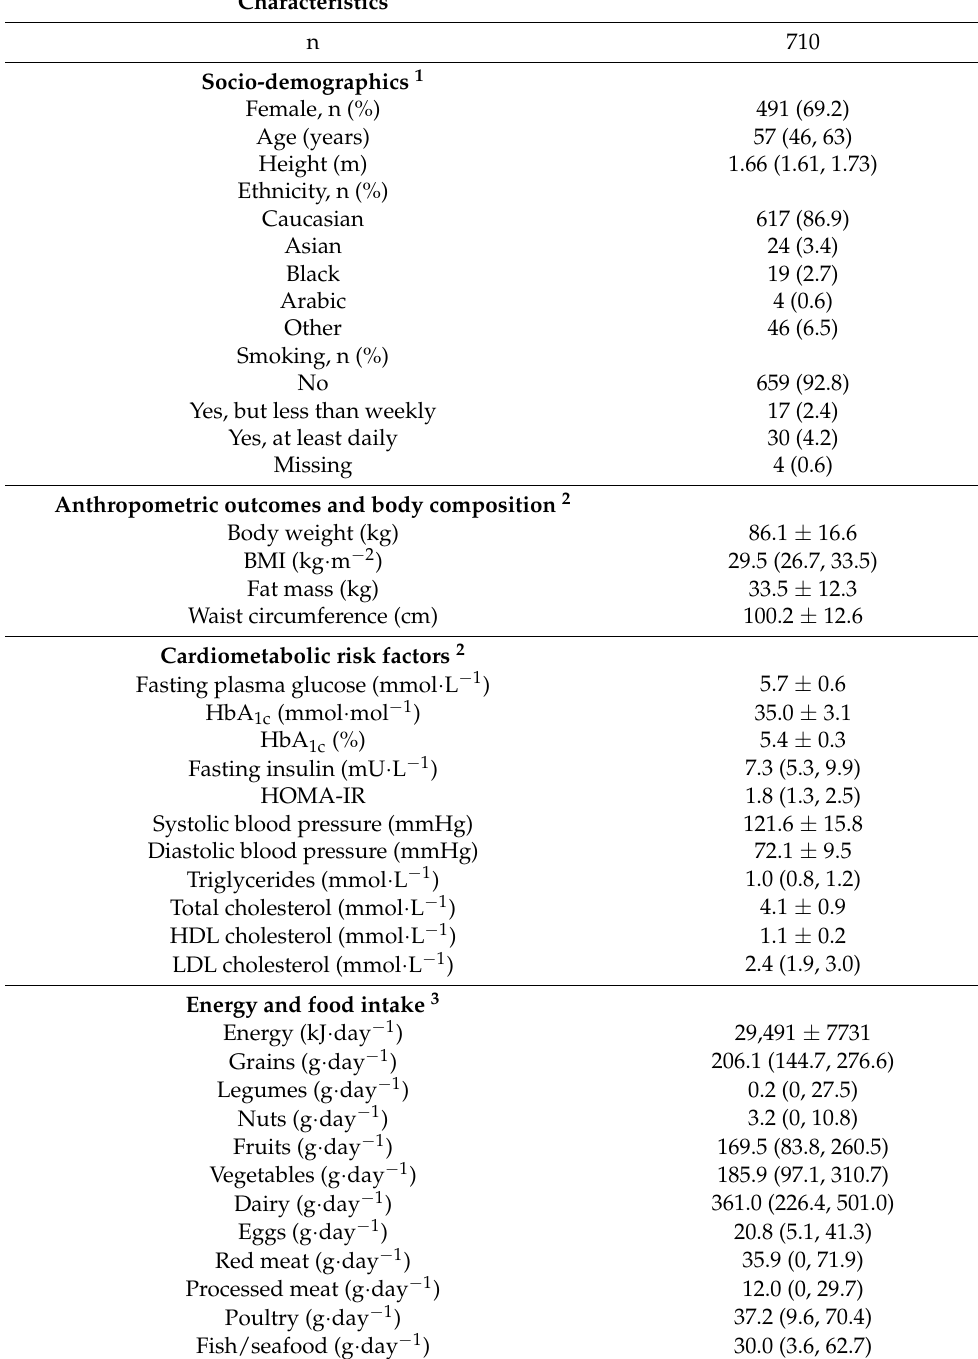
Table 2. Characteristics of participants at baseline (0 weeks), the start of weight-loss maintenance (8 weeks), or 26